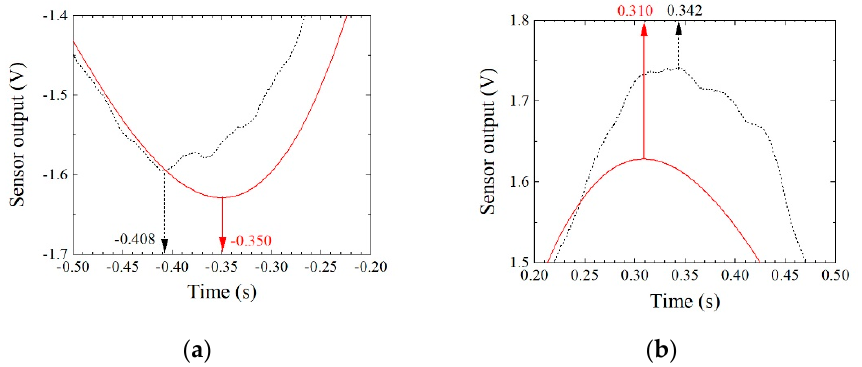
Figure 27. Position difference between raw data and curve-fitting data. ( a ) Minimum point. ( b ) Maximum point.